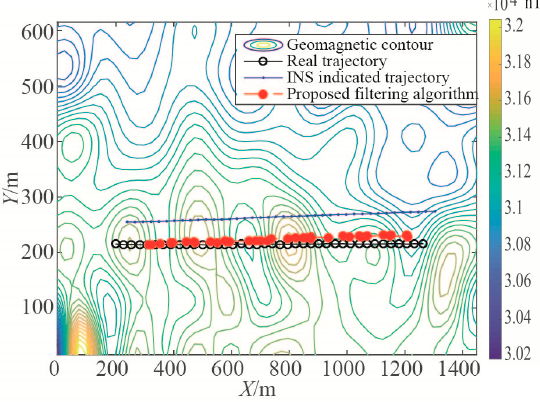
Figure 14. Total error after geomagnetic filtering. Electronics 2019 , 8 , x FOR PEER REVIEW